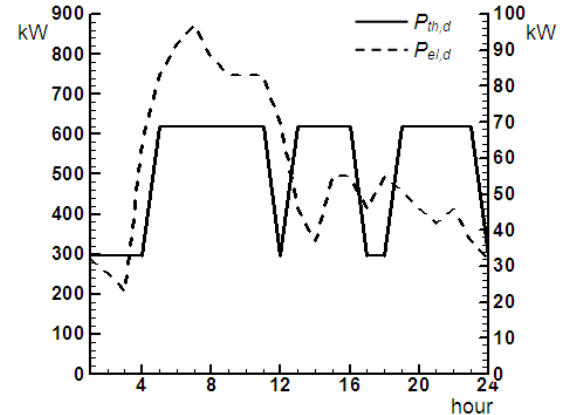
Figure 9. End user electric (P winter